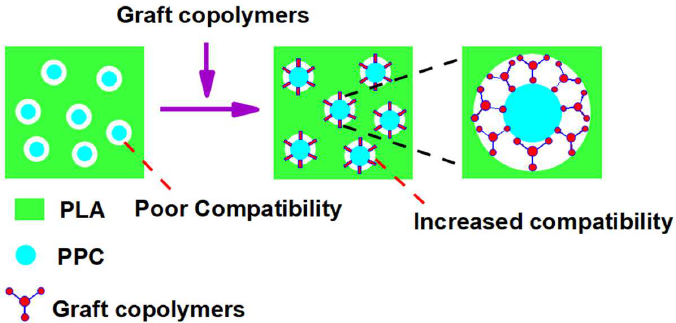
Figure 5. The compatibilization effect of PLA-g-GMA graft copolymer on PLA/PPC blends.